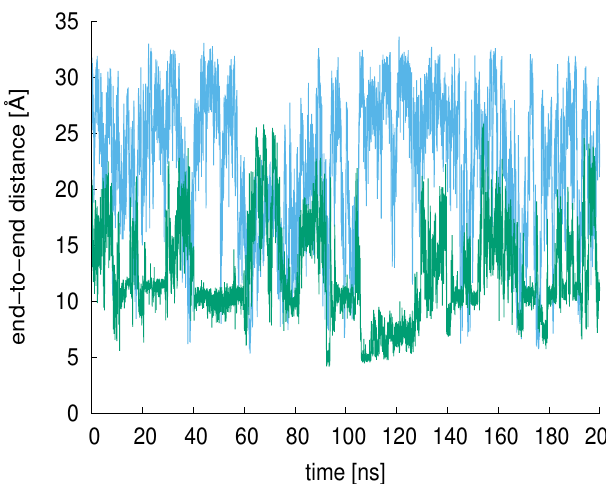
Figure 5. The end-to-end distances of the XAO peptide (blue) and 9-mer (green) are shown for 200 ns MD in aqueous solution. The average XAO end-to-end distance is 22.6 Å (calculated from 900 ns simulation period); the average 9-mer end-to-end distance is 12.4